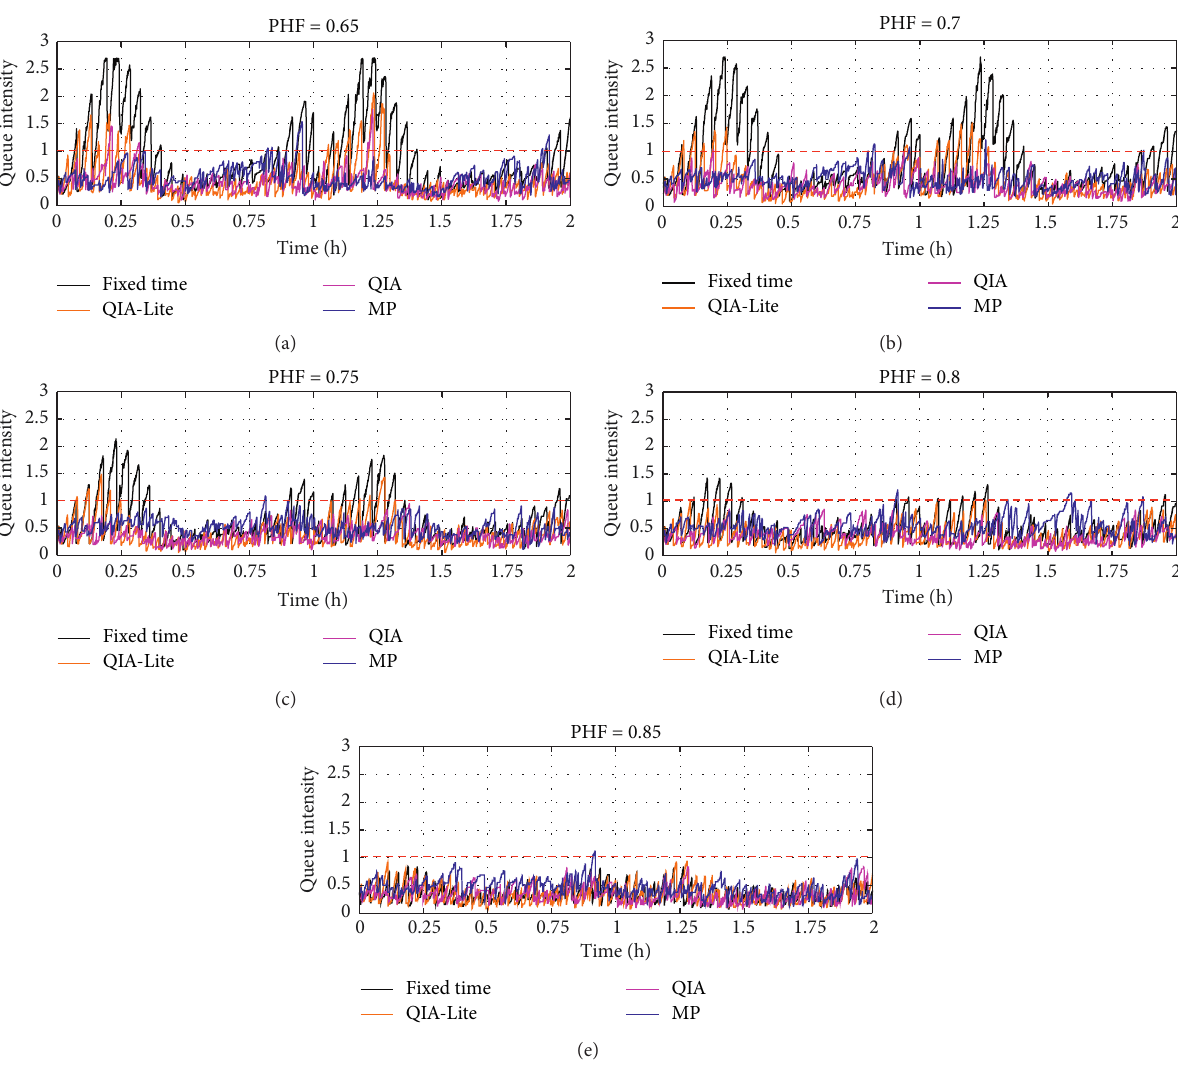
Figure 7: Queue intensity variation over the study period.